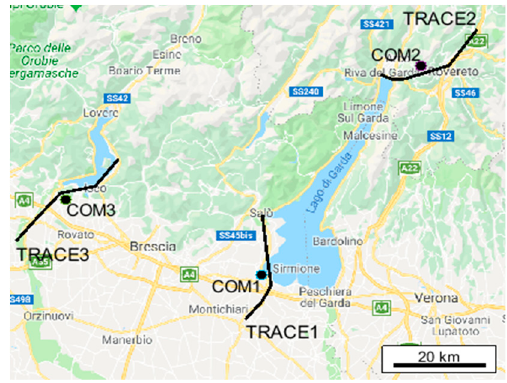
Figure 2. Traces having comparable distances COM1–COM2 and COM1–COM3 but behaviorally different meaning: TRACE1 and TRACE2 are located in the proximity of the same area of interest represented by the same lake.